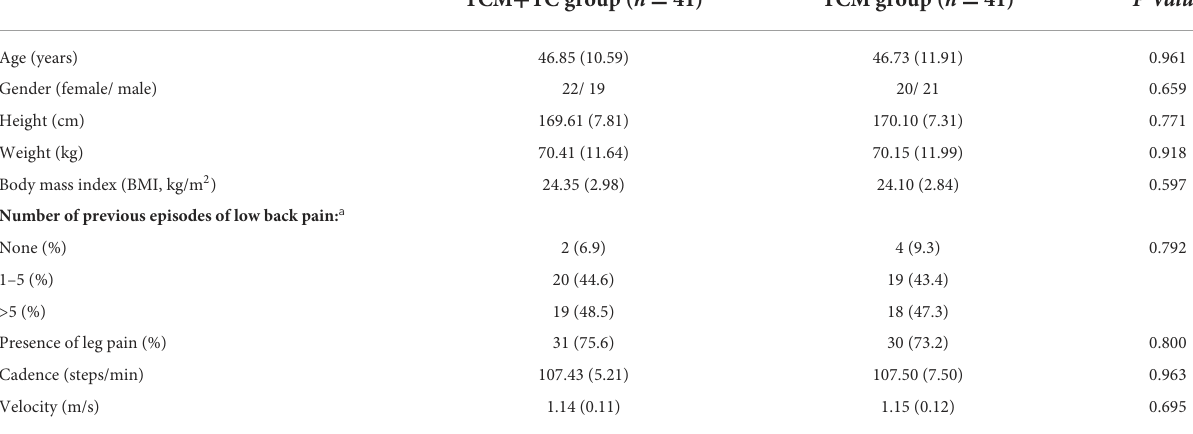
TABLE 5 Baseline demographic characteristics of participants in biomechanical testing ( N =